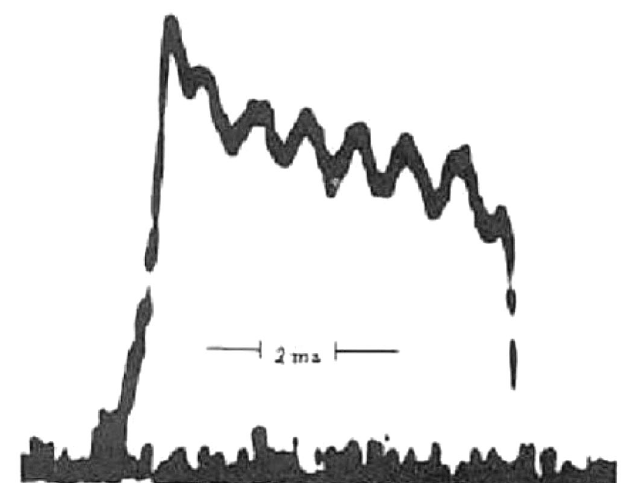
FIG. 5. Observation of coupled electron-proton instability at the CERN ISR in 1972 [22]; shown is the beam-induced signal from a horizontal pickup; the coasting beam current was 12 A and the beam energy 26 GeV. A horizontal span of 2 ms is indicated. Fig. 6. The beam loss occurs on a time scale of 10 – 100 (cid:7) s above a threshold charge of 1 : 5 (cid:1) 10 13 protons. The LANL